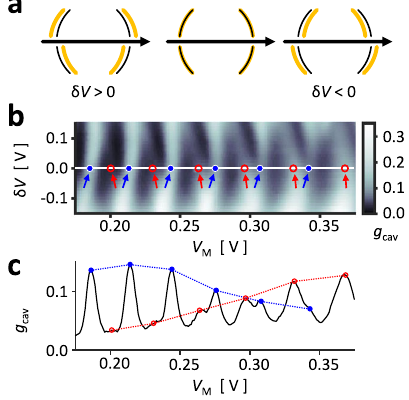
Fig. 3 | Resonance energy spectrum. a Source-drain bias spectroscopy of the cavityfollowingthemeasurementschemein b .Abias V DC wasapplied toreservoir SwhilekeepingreservoirsO1andO2 fl oatedinordertorestrictthevoltagedropto across the mirrors. Diamond shapes (diagonallines in a ) are obtained by following the conductance peaks; the positively (negatively) sloped line corresponds to the cavitymodealigningwithreservoirS(D).Theheightofthediamonds Δ E n givesthe energy spacing between the cavity modes, labeled n . c Energy spacing for peaks without additional fi ne structures reveal a linearity between Δ E n and n , with the slopefor L =498nm giving the best fi t. The agreement with our sample dimension con fi rms that V M mainly modulates the longitudinal Fabry – Pérot